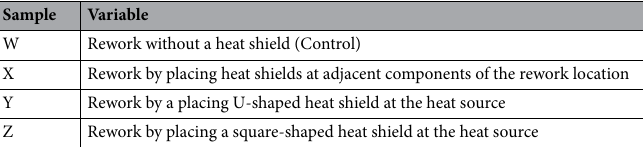
Table 1. Material samples and variables.